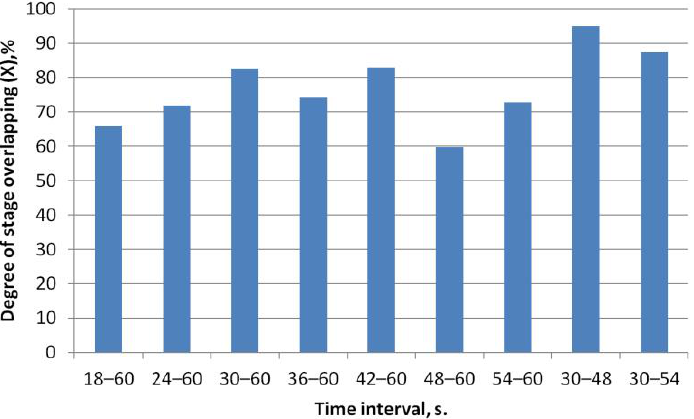
Figure 13. Degree of overlapping of the devolatilization and char residue combustion stages in a single-stage conversion process. The time intervals used to evaluate the degree of overlapping are indicated.